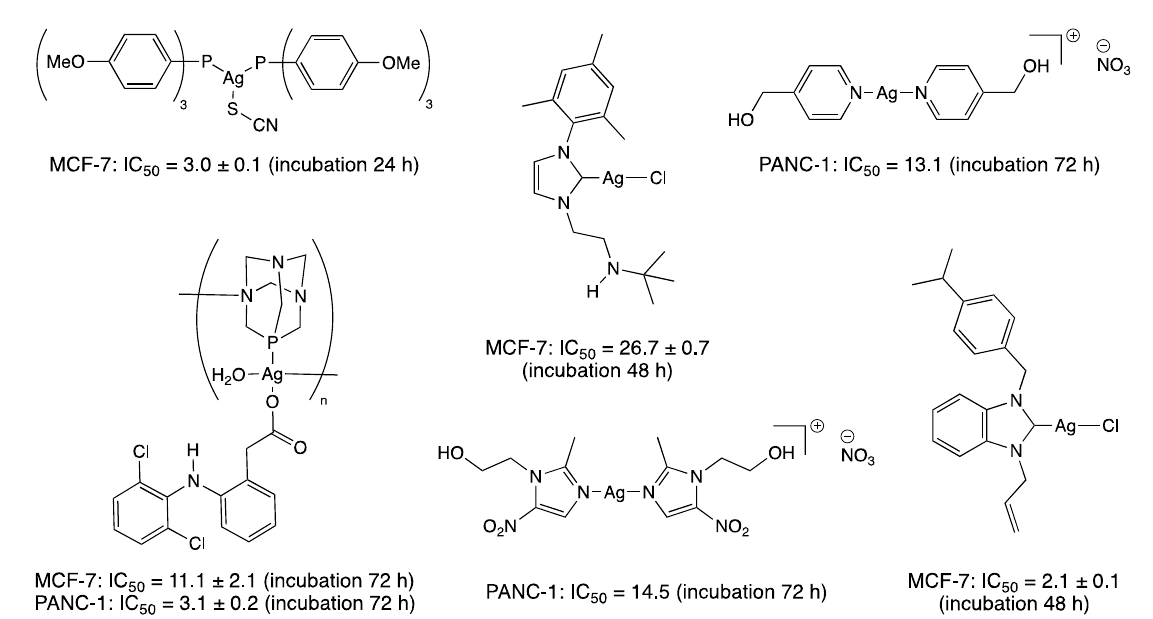
Figure 7. Examples of reported silver(I) complexes with anticancer activities.